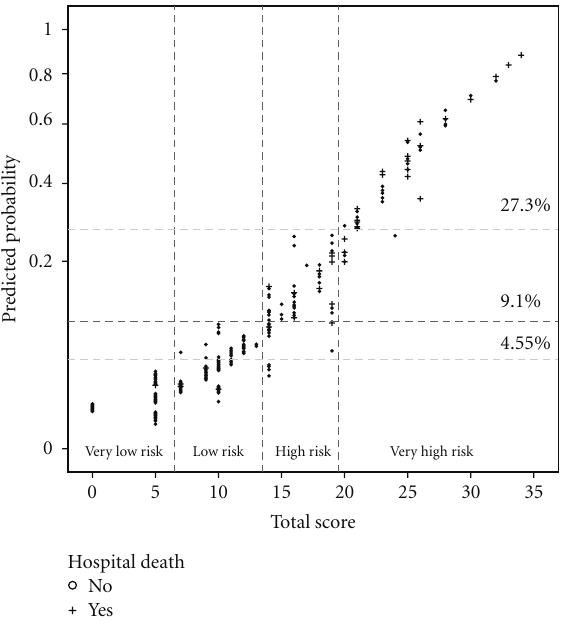
Figure 2: Scatterplot of predicted probability of postoperative 30- day death ( y -axis, depicted with exponential scale) against total score per patient ( x -axis). Horizontal dotted lines indicate the levels of death probability corresponding to the average observed mortality (9.1%), half of it (4.55%), and 3-fold higher mortality (27.3%). The four prognostic classes (thresholds indicated by vertical dotted lines) were identified by (1) the scores corresponding to a predicted mortality not exceeding 4.55% (0 or 5 points); (2) the score range including cases with a predicted mortality above 4.55%, but none beyond 9.1% (7–13 points); (3) the score range whereby predicted mortalitiesexceeded 9.1%; however, with no case over 27.3% (14–19 points); (4) the scores associated with predicted mortality range exceeding 27.3% (score ≥